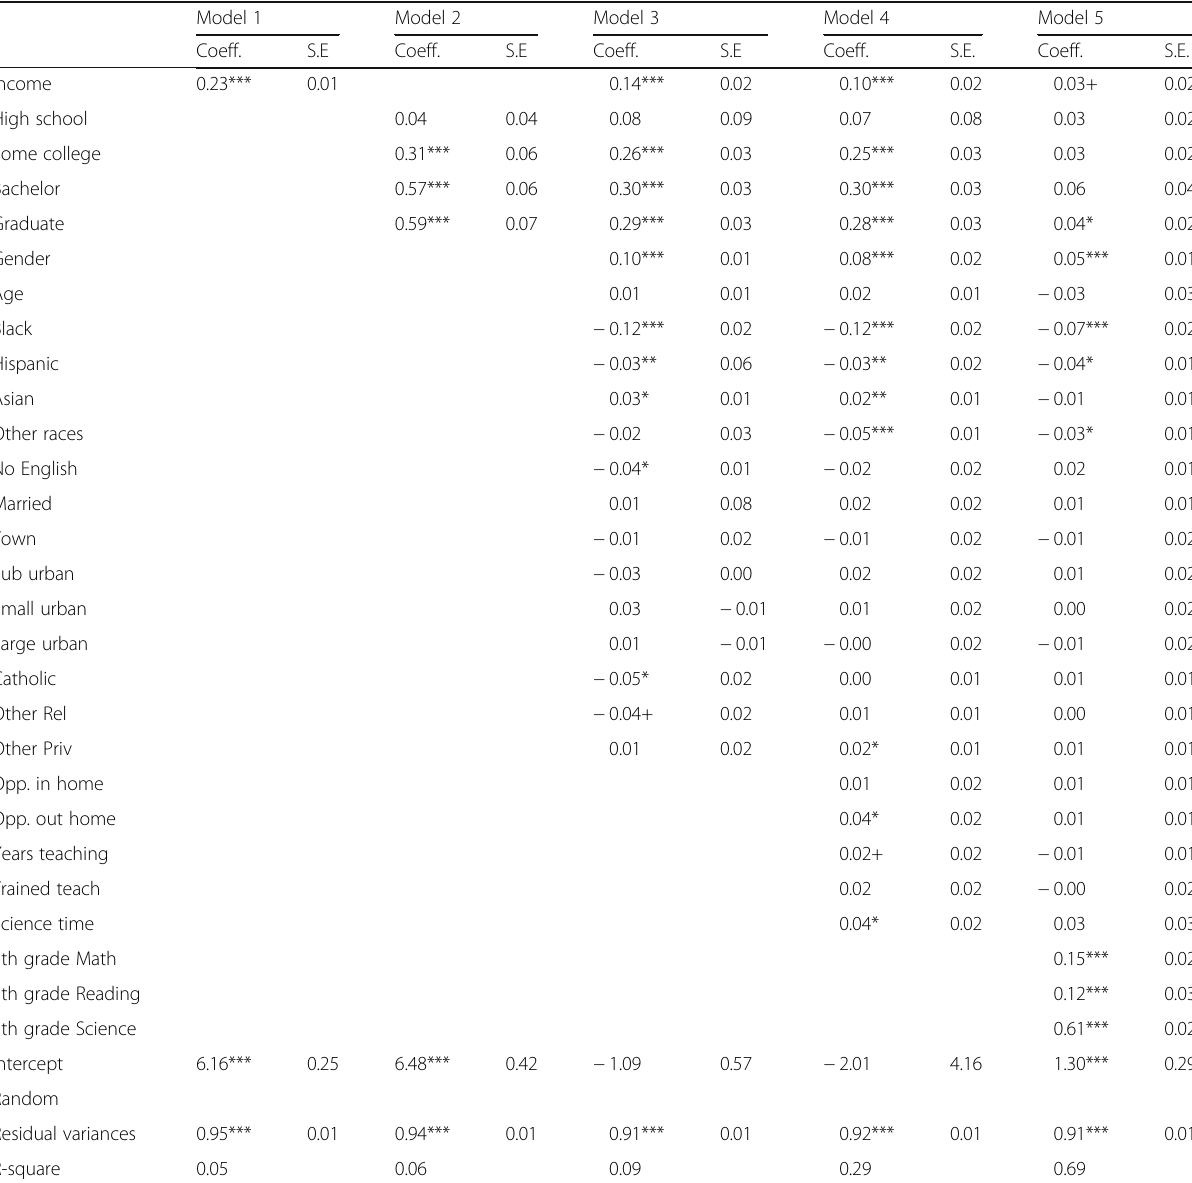
Table 4 Results for science at eighth